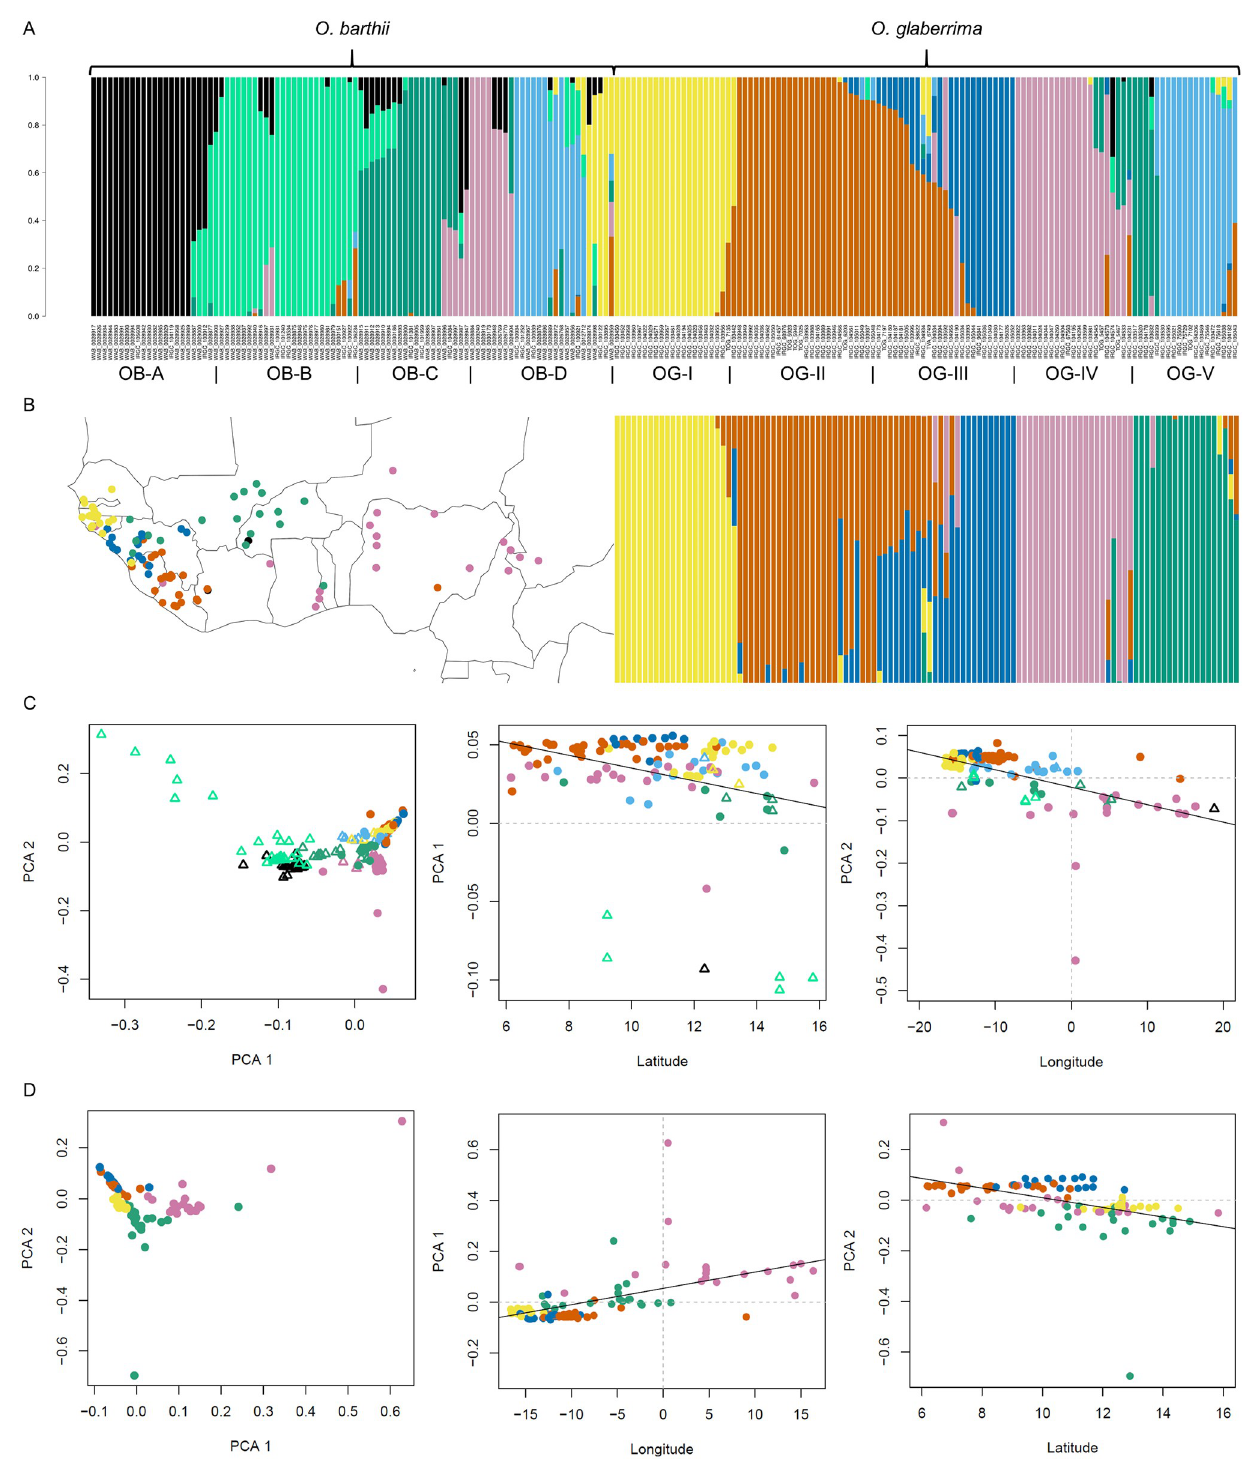
Fig 3. Structure and geographic clustering of genetic variation in O . barthii and O . glaberrima . A. Admixture analysis with K = 8 ancestral populations of wild and domesticated rice accessions combined. B. Admixture analysis with K = 5 ancestral populations of domesticated rice accessions only and their corresponding collections sites. Accessions were assigned to a cluster according to their genetic background, with the colour of each sample representing the ancestral population (K = 5) that accounted for the majority ( > 50%) of pruned SNPs in that accession. C. PCA of all geo-referenced accessions of O . glaberrima (dots, filled) and O . barthii (triangles, open) together. The first principal component is correlated significantly with latitude and the second principal component is correlated significantly with longitude. D. PCA of all geo-referenced O . glaberrima accessions separately. The first principal component is correlated significantly with longitude and the second principal component is correlated significantly with latitude.